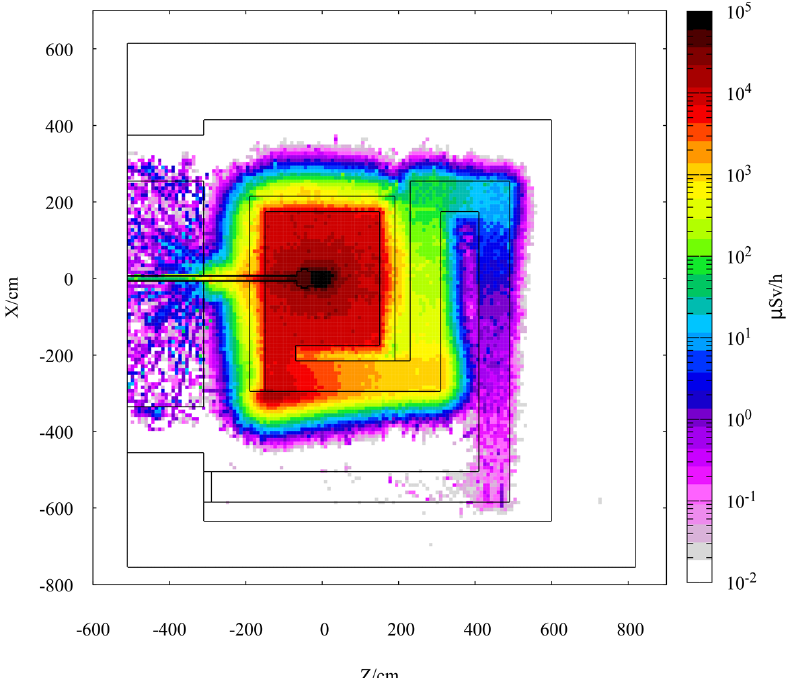
Figure 14. Induced ambient dose equivalent rate ( μ Sv/h) at beamline level (y = [ − 4.7, 1.6]) at 0 s post-EOB.